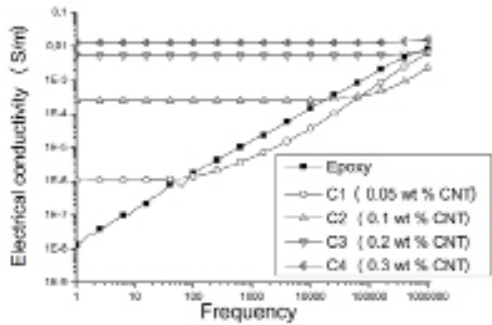
Figure 3. Electrical conductivity as function of frequency for neat epoxy and epoxy/CNT